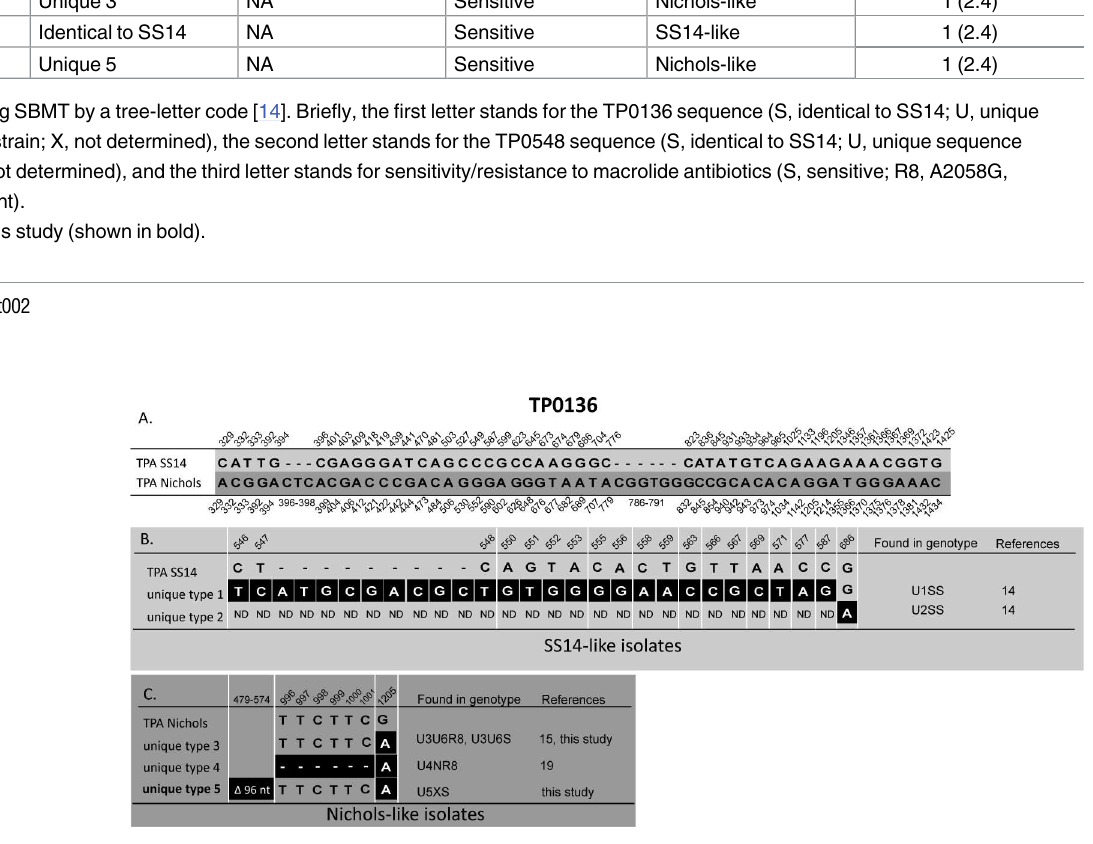
Fig 2. Alignment of TP0136 unique sequences identified to date [this study, 14, 15, 19]. Only positions containingnucleotidevariantsare shown. A. Nucleotide differences betweenreferencestrain TPA SS14 and TPA Nicholsin the regioncharacterized usingSBMT (at coordinates264–1469 according to the TPANIC_0136; CP004010.2). Coordinates shownabovecorrespond to TPASS_0136 (TPA SS14; CP004011.1) and coordinates shown belowcorrespond to TPANIC_0136 (TPA Nichols;CP004010.2). B. Nucleotide differences in SS14-like uniquesequences. Coordinatescorrespond to TPASS_0136(TPA SS14; CP004011.1). ND, was not determined due to the limited amount of sampleDNA. The white lines betweencoordinatesindicatethe non- continuousnucleotidepositions. C. Nucleotidedifferences in Nichols-like uniquesequences. Coordinates correspond to TPANIC_0136(TPA Nichols; CP004010.2). The new uniquesequenceidentifiedin this study is shownin bold. The white lines betweencoordinates indicatethe non-continuous